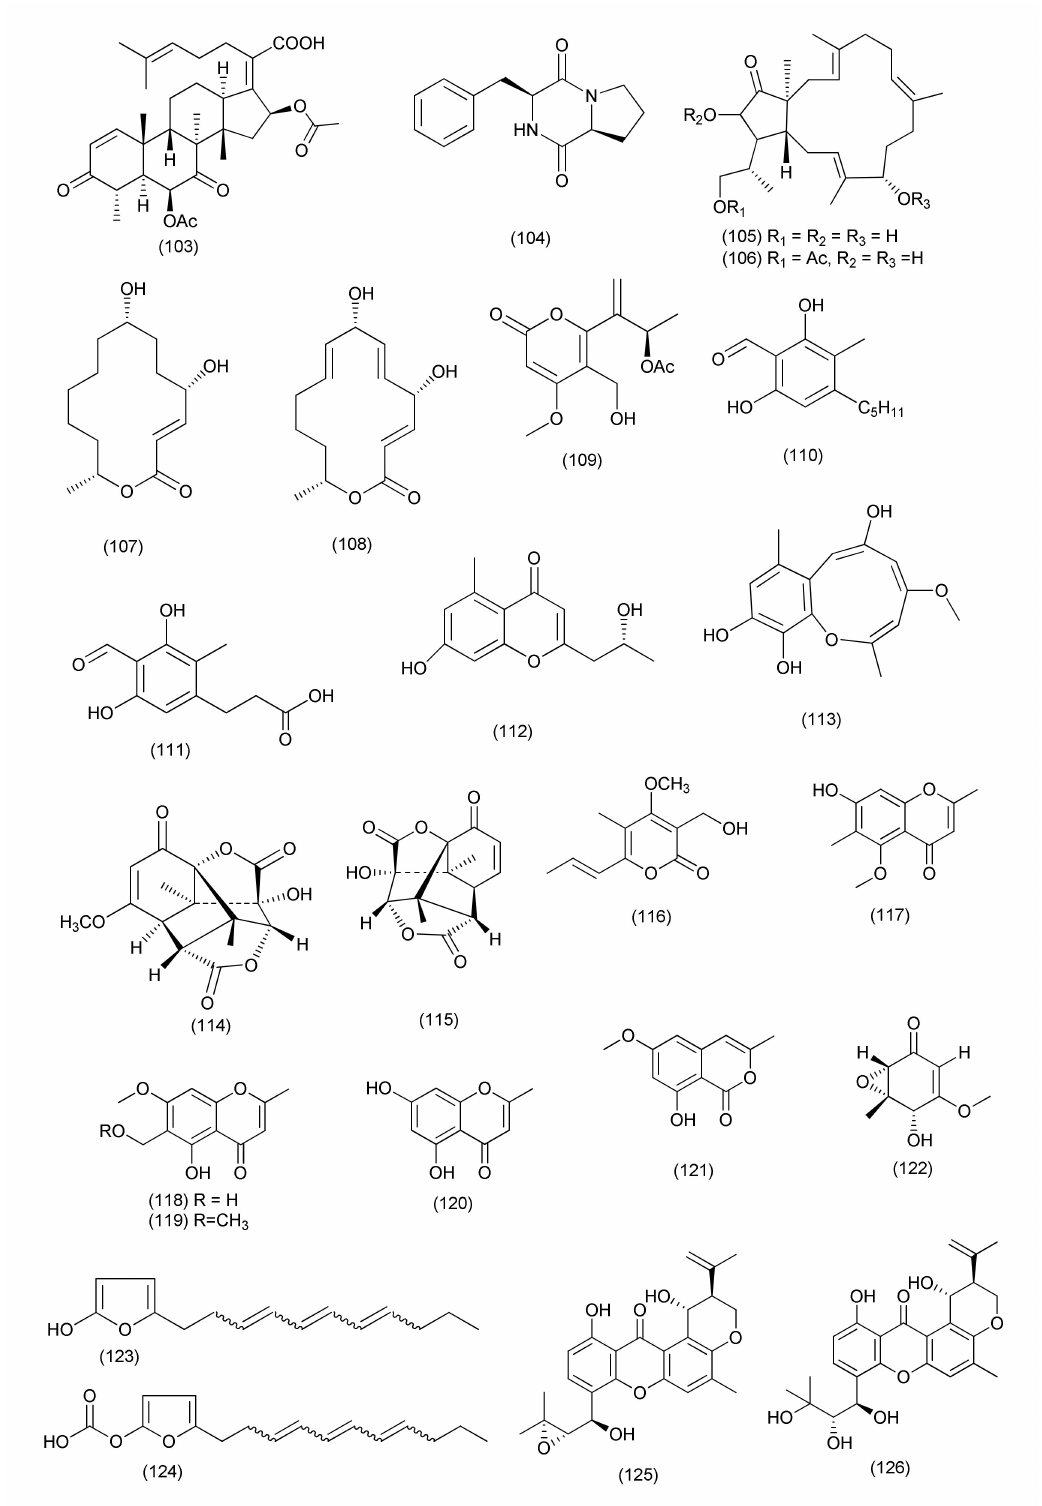
Figure 7. Structures of metabolites 103 – 126 isolated from Ascomycetes. New polyketides aplojaveediins A and F ( 110, 111 , Figure 7) were purified from the Aplosporella javeedii associated with the Orychophragmus violaceus . Compound 110 exhibited average activity against the sensitive Staphylococcus aureus strain ATCC 29213, the methicillin-resistant and vancomycin-intermediate sensitive (MRSA/VISA) S.